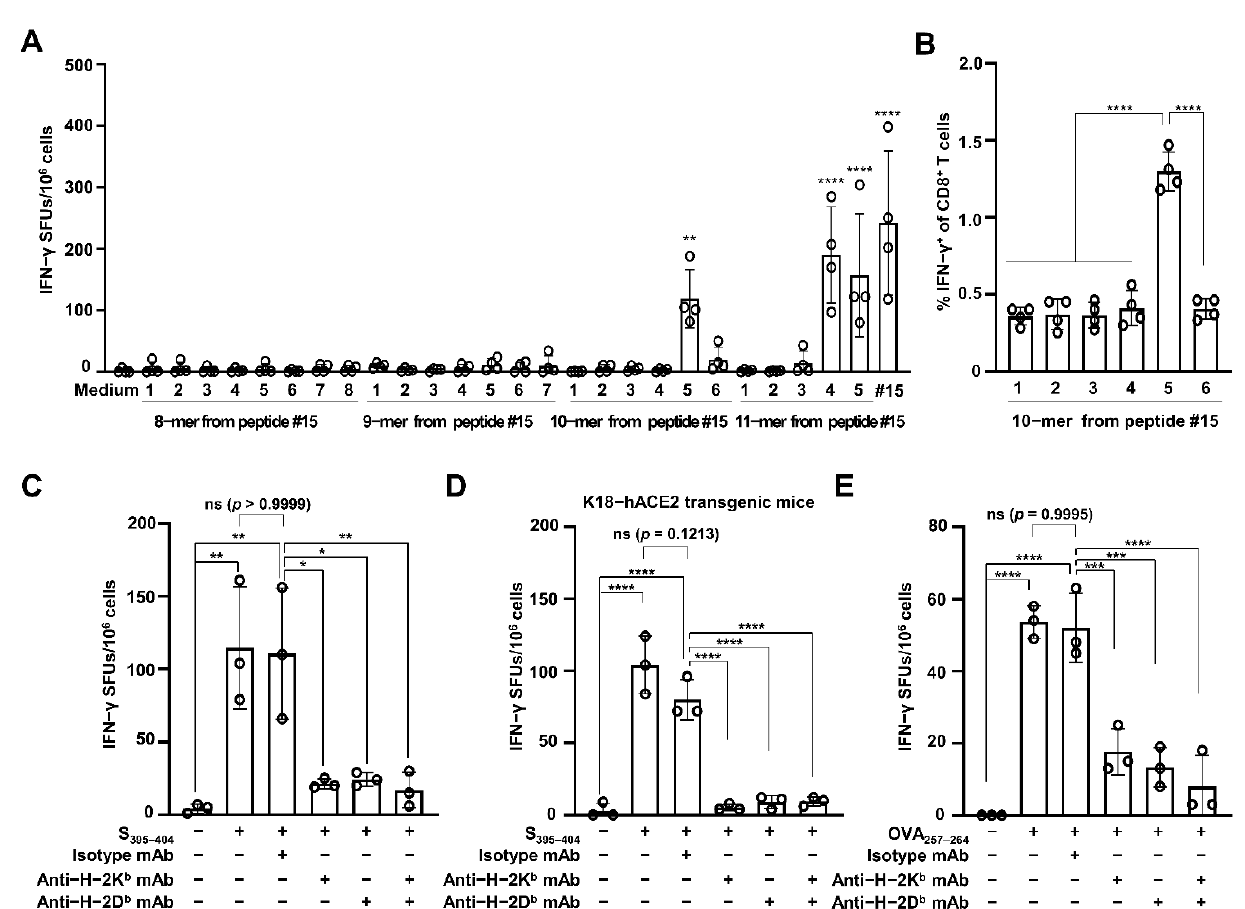
Figure 2. SARS-CoV-2 S 395–404 increases H-2K b /D b -restricted IFN- γ production. ( A ) Splenocytes were harvested from